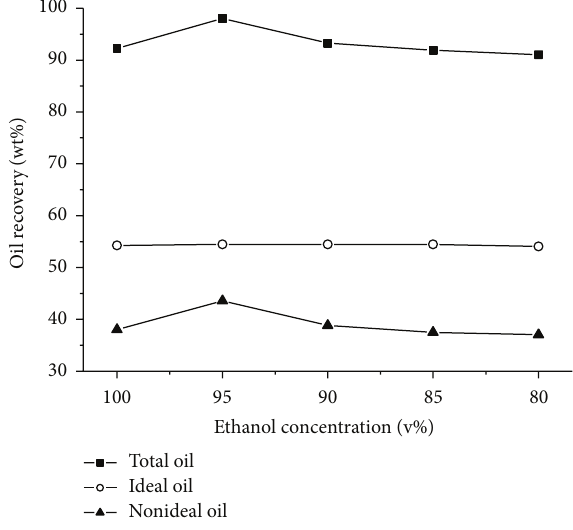
Figure 1: Effect of ethanol concentration.